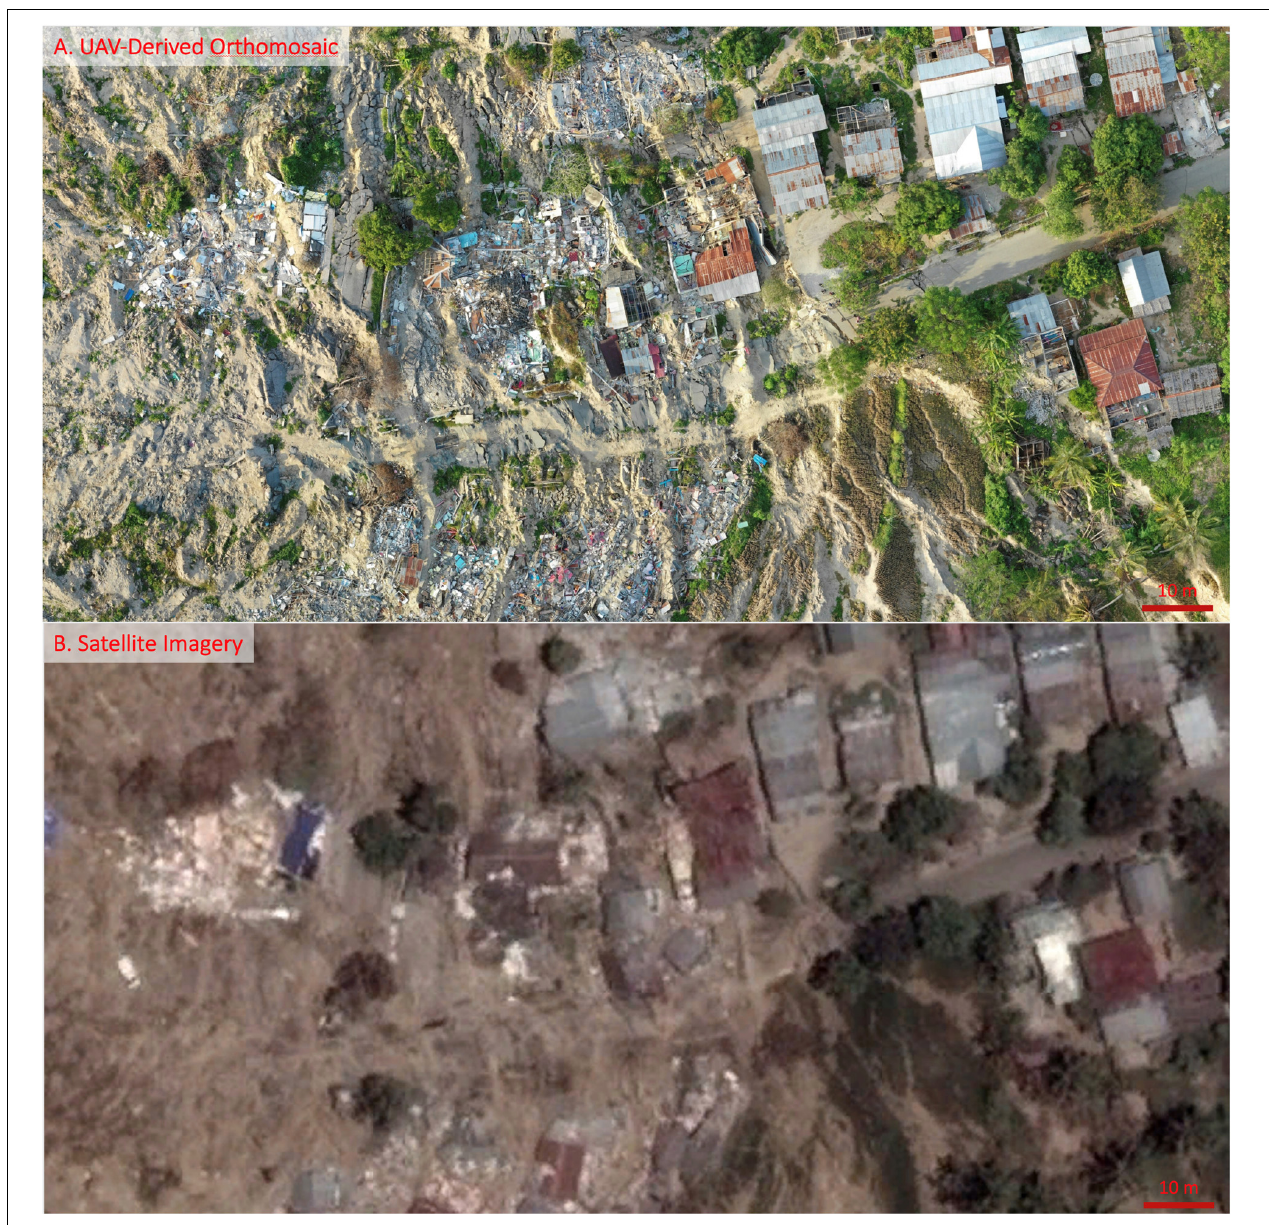
FIGURE 9 | (A) Example of a portion of a high-resolution ( ∼ 2 cm pixel) orthomosaic of a flowslide. (B) Shown for comparison is a post-earthquake satellite image of the same scene provided by Google Earth crisis response program. Note the dramatic difference in resolution between the